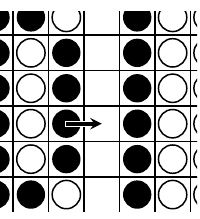
Figure 33. Parking wall’s BLACK